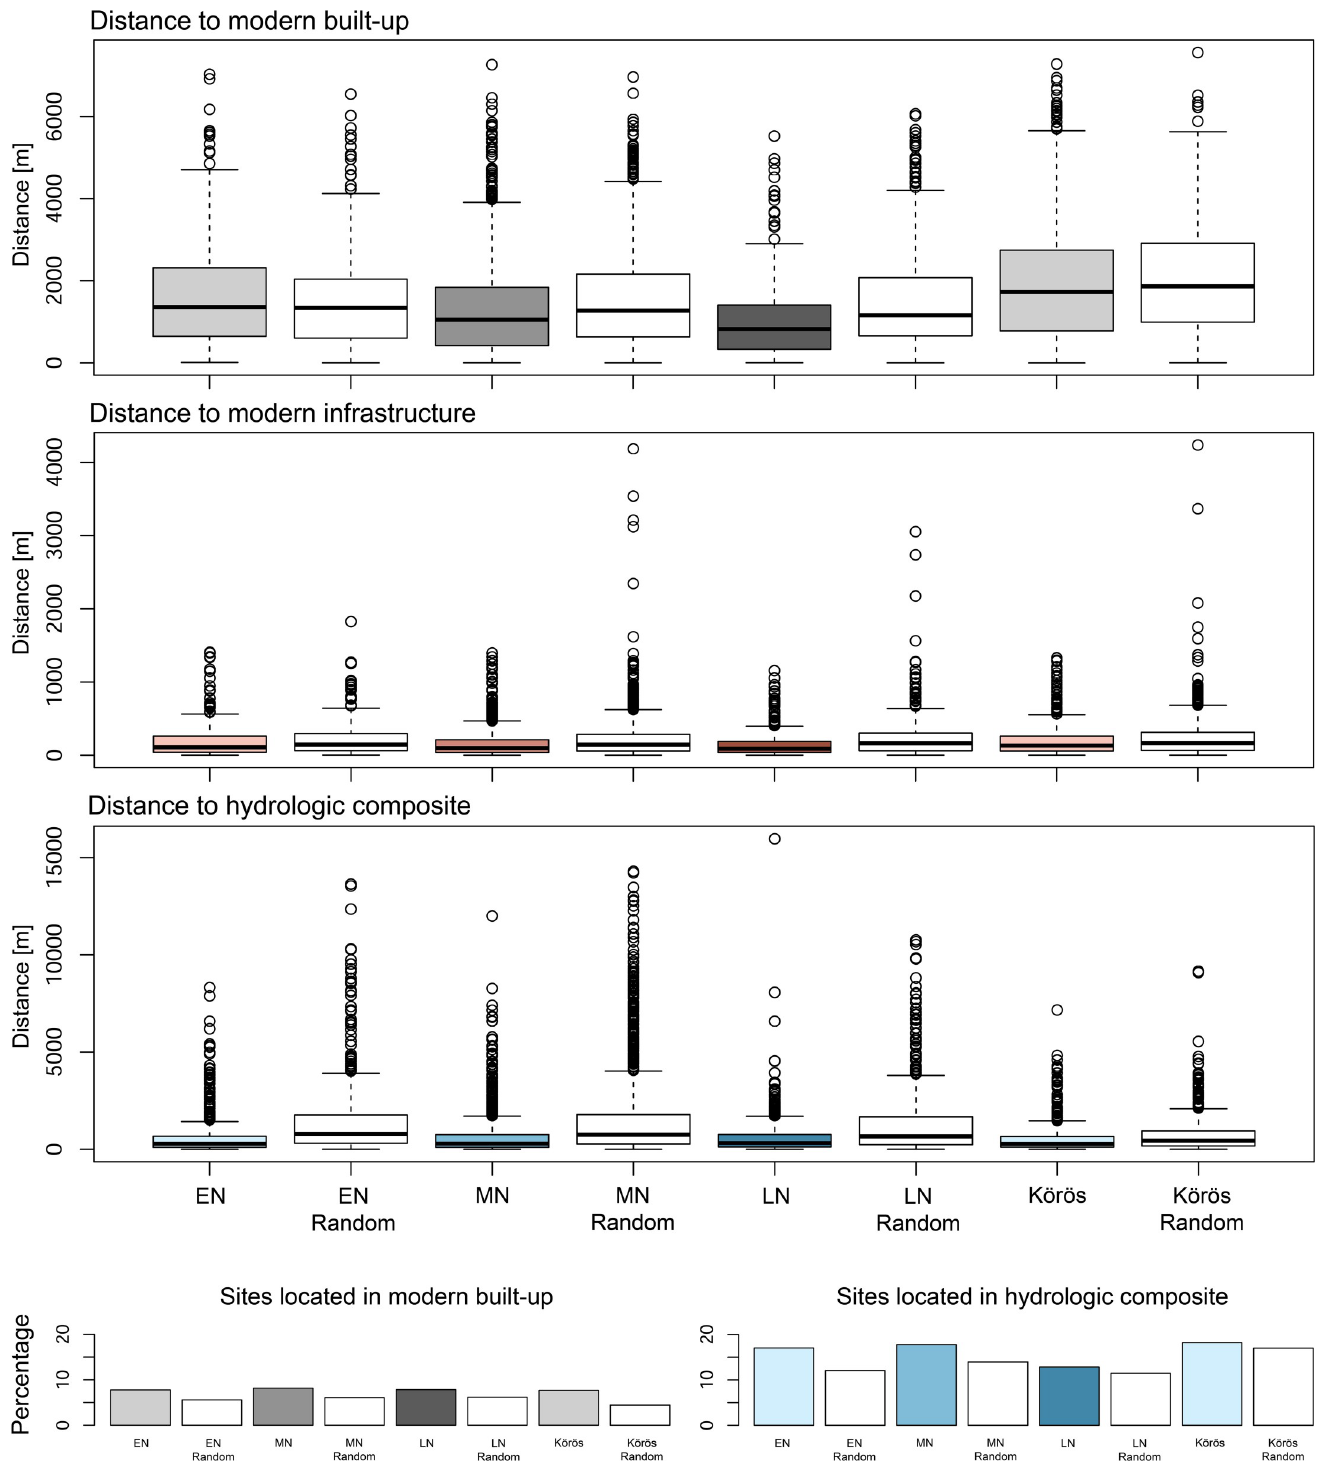
Fig 11. Distance boxplots of all EN, MN, LN, and the Ko¨ro¨s sample sites and their random comparison data to the modern built-up, infrastructure, and the hydrologic composite dataset. The distance matrix includes all sites that are located outside the respective areas. The barplots show the percentage of sites that fall into the respective extent of the area and were excluded from the distance